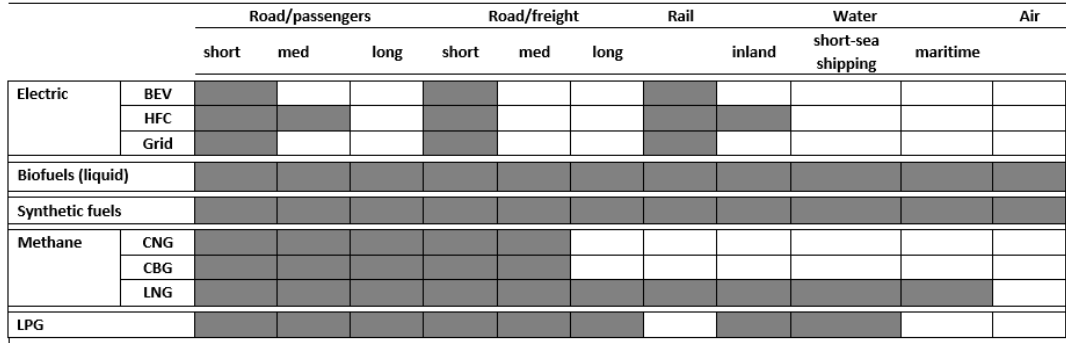
Figure 2. Coverage of different transport modes by different alternative fuels [19]. BEV—battery electric vehicle; HFC—hydrogen fuel cell; CNG—compressed natural gas; CBG—compressed biogas; LNG—liquefied natural gas; LPG—liquefied petroleum gas.